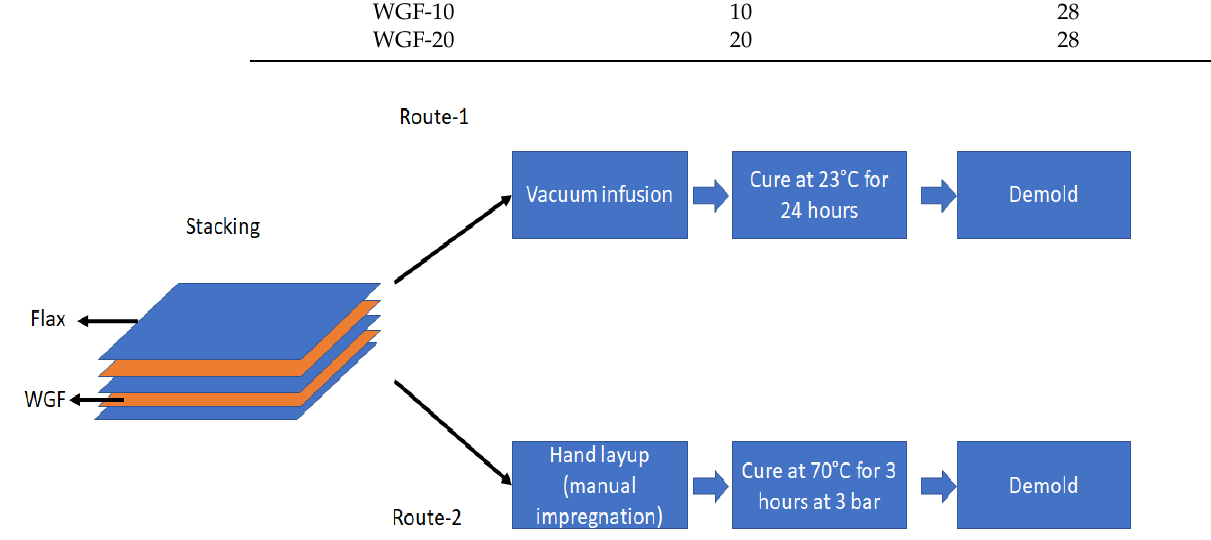
Figure 3. A schematic of manufacturing routes for WGF